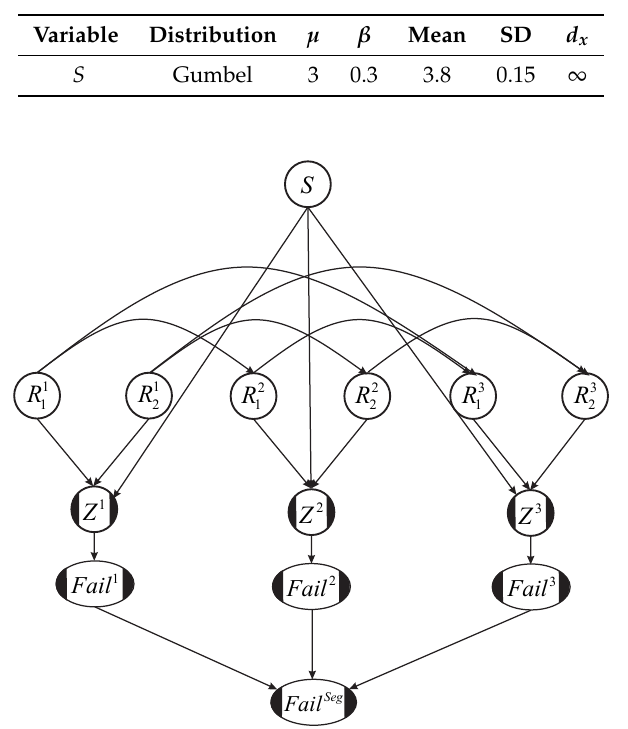
Table 2. Gumbel parameters µ (location parameter) and β (scale parameter), distribution mean and standard deviation (SD), and correlation length d x for variable S .